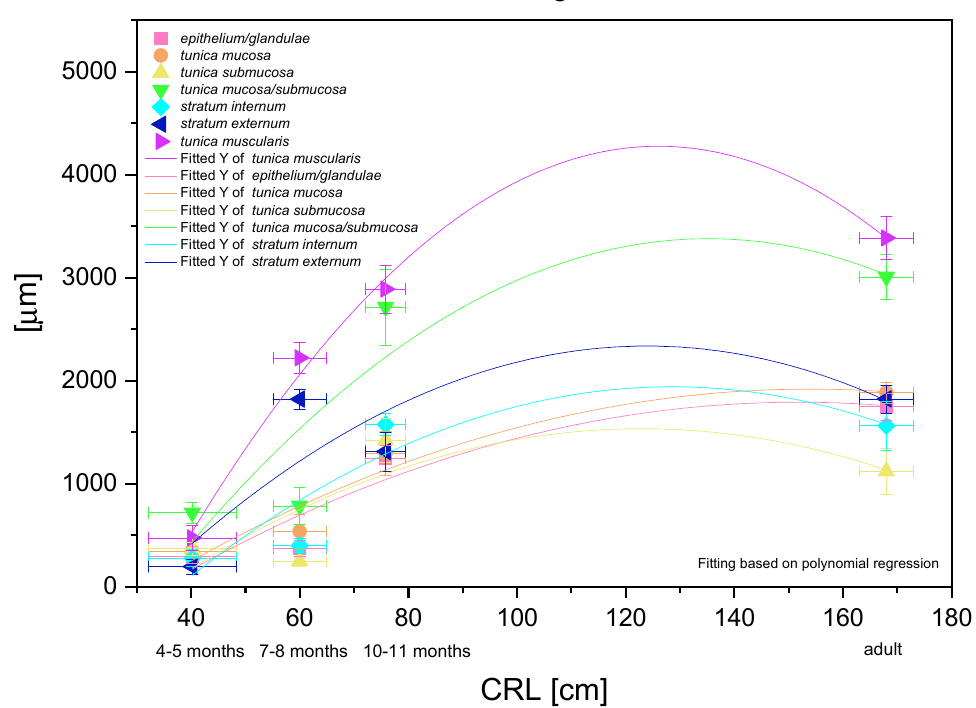
Figure 15. Histometric analysis of the stomach wall structures in the plicated edge margin/the cardiac part of the stomach ( margo plicatus ). The figure shows nonlinear regression curves of all metric parameters in all three age groups and the adult reference group.